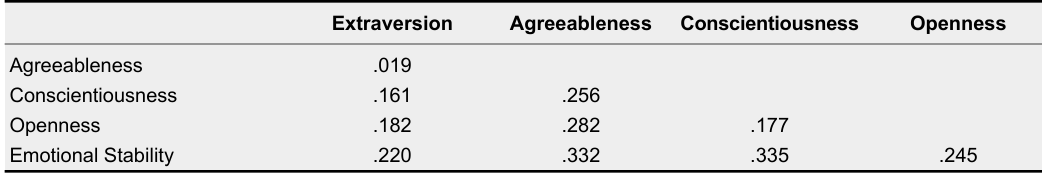
Pearson Correlations Among Big Five Traits (N =